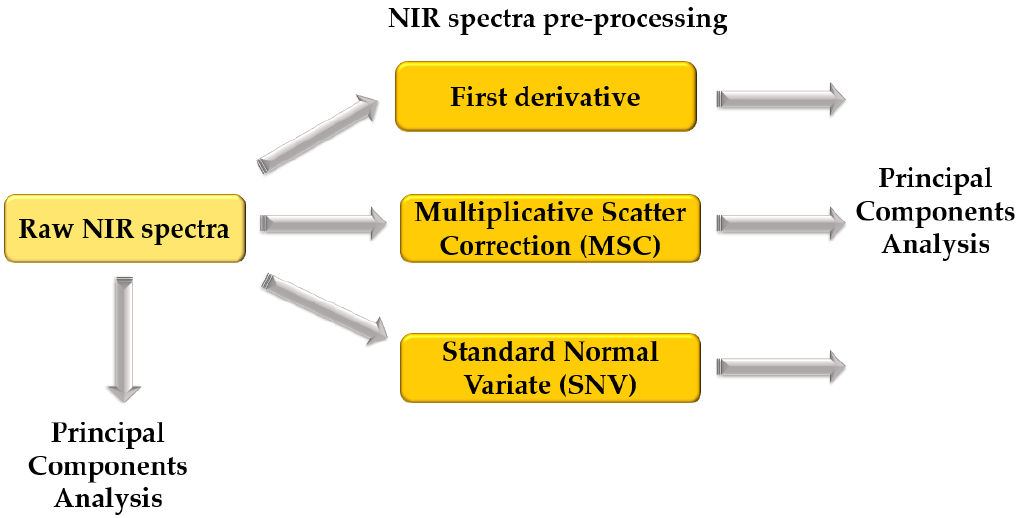
Figure 3. Basics of spectral data analyses.